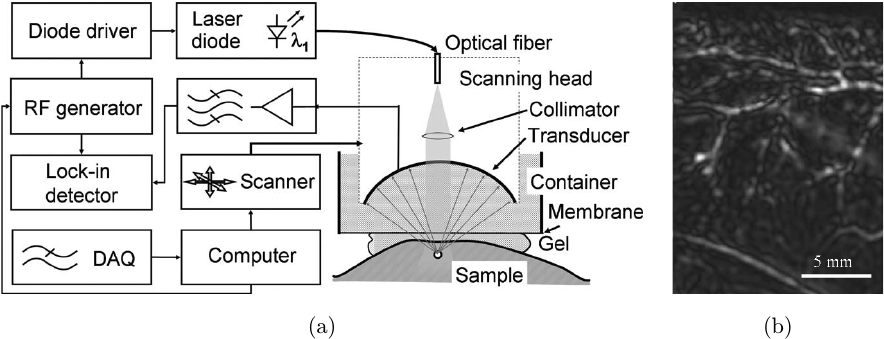
Fig. 3. (a) Schematic of the CW LD-PAT system and (b) amplitude image of a rabbit ear vasculature (images adapted from Ref. 43).